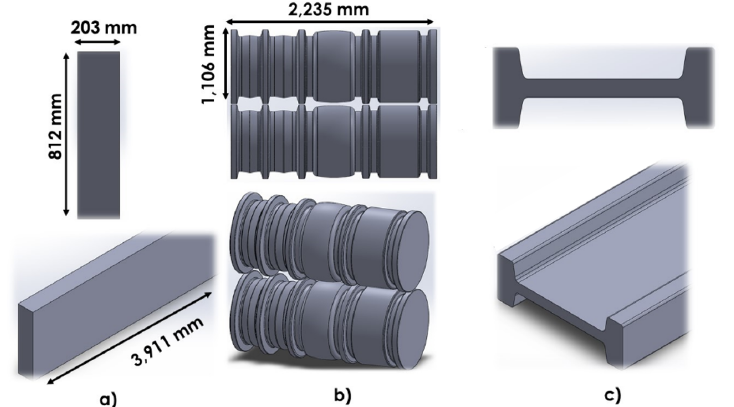
Figure 1. Geometry and dimensions: ( a ) beam blank; ( b ) rolls; ( c ) schematic of the IPR profile.